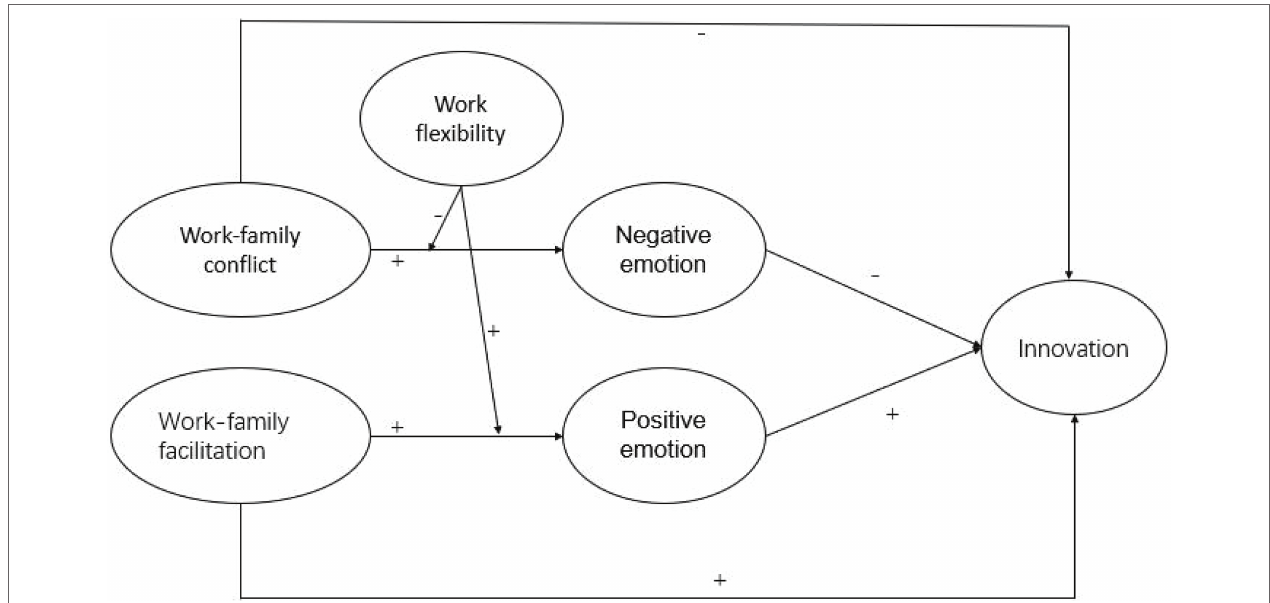
FIGURE 1 | Theoretical